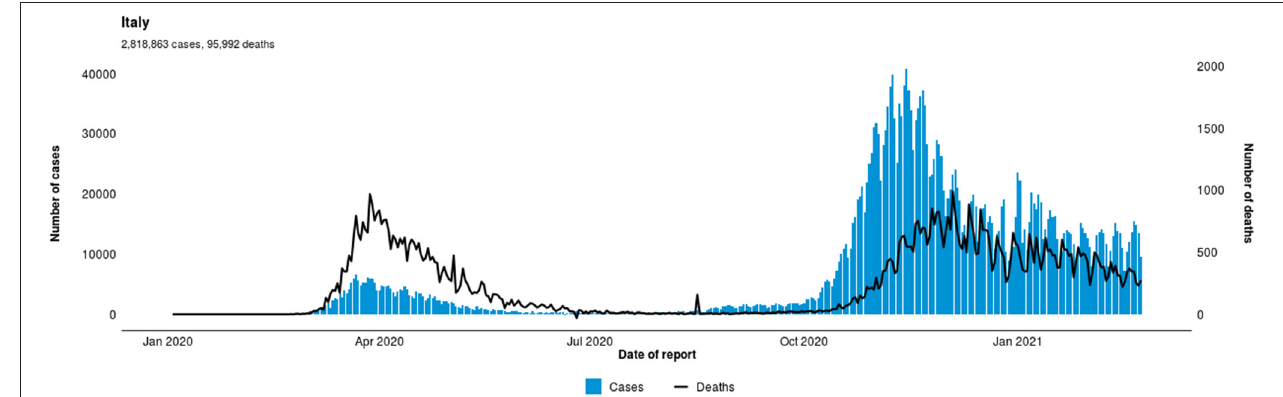
FIGURE 1 | Situation by Country, Territory, and area sources (WHO 2020).